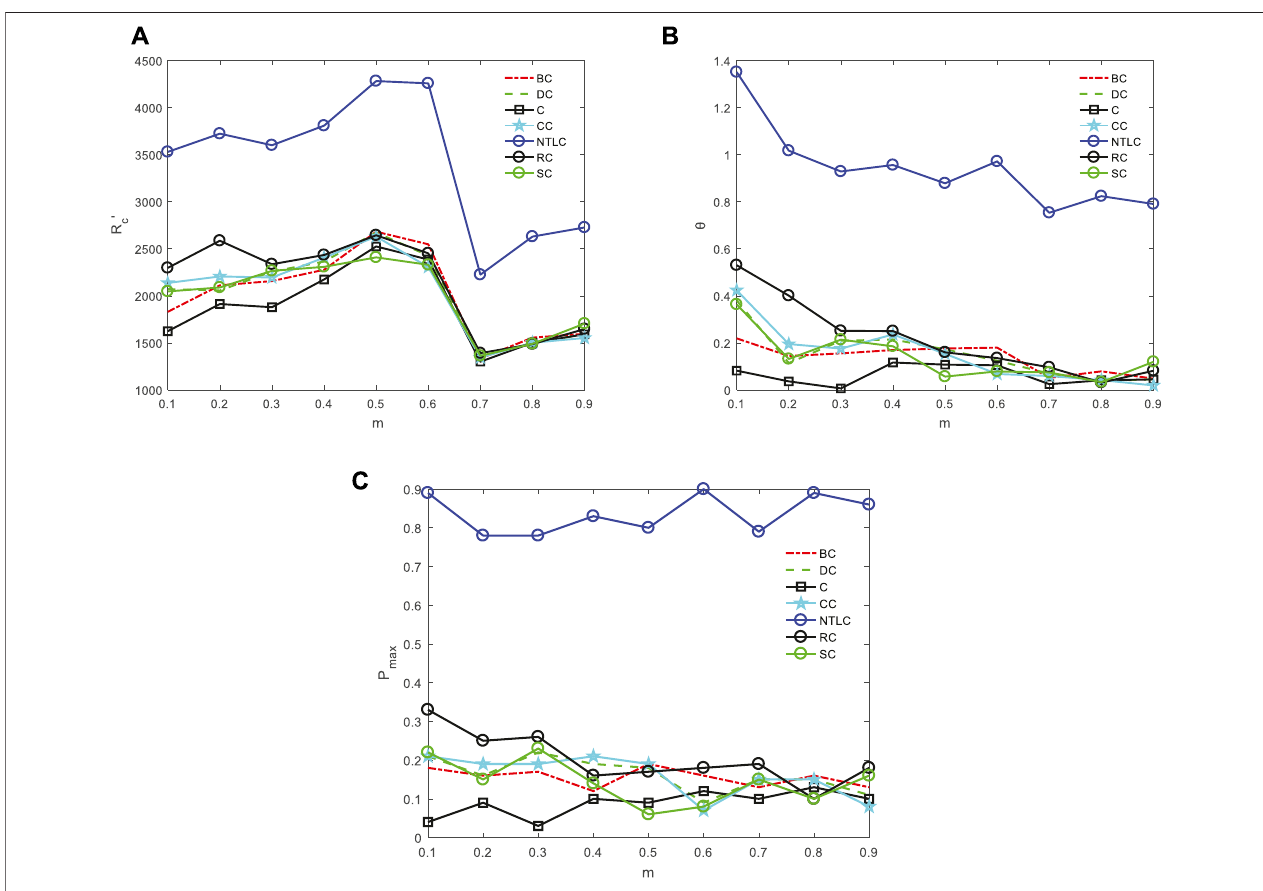
FIGURE 3 | Repair effect of seven methods when some nodes in the network have random failures. (A) Maximum throughput of the network after repairing; (B) maximum throughput increasing rate of the network after repairing; (C) probability of fi nding the ground-truth best repairing node. The results are averaged over 100